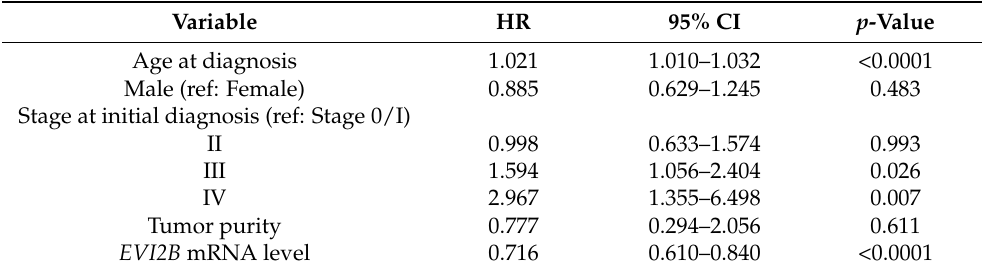
Table 2. Multivariate Cox regression analysis on overall survival on the TCGA dataset.